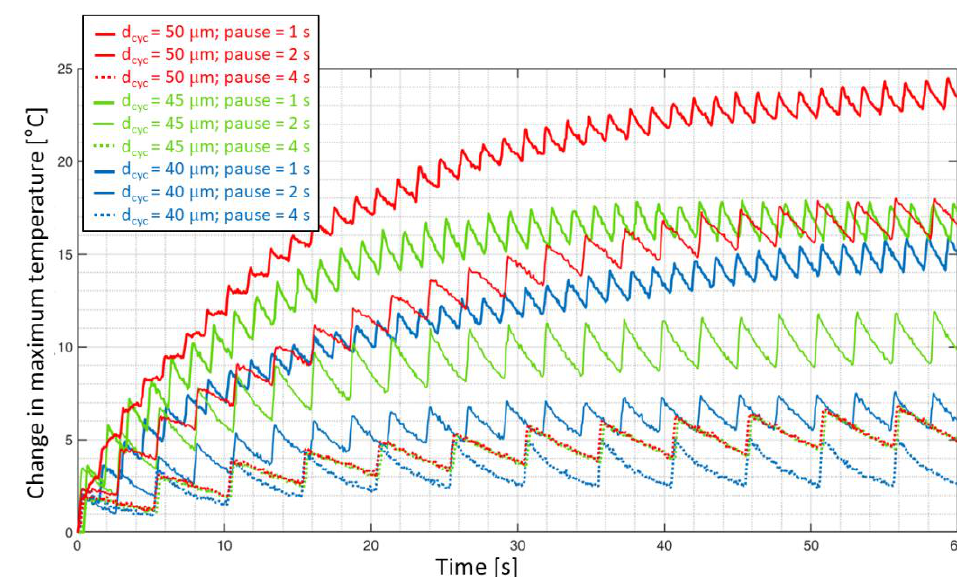
Figure 8. A time–temperature plot of the VHCF specimens that were tested at 20 kHz in three different load amplitudes and three pause times during the first minute.